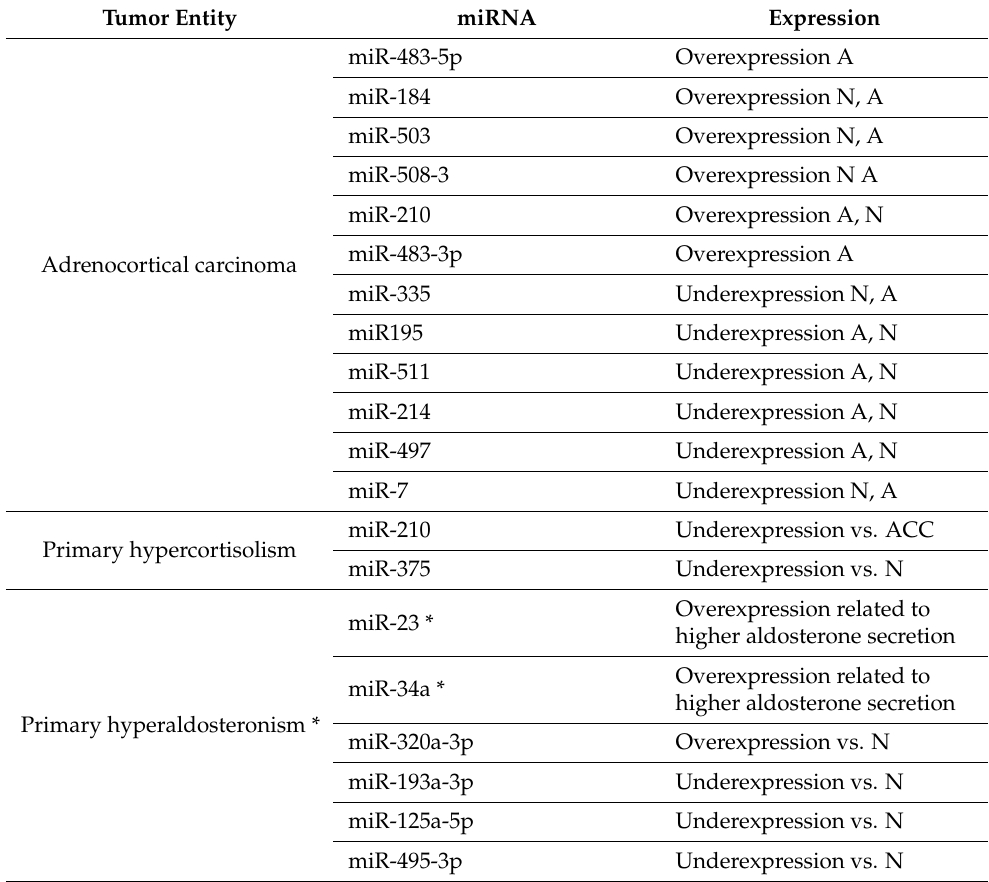
Table 2. Tissue miRNA in adrenocortical